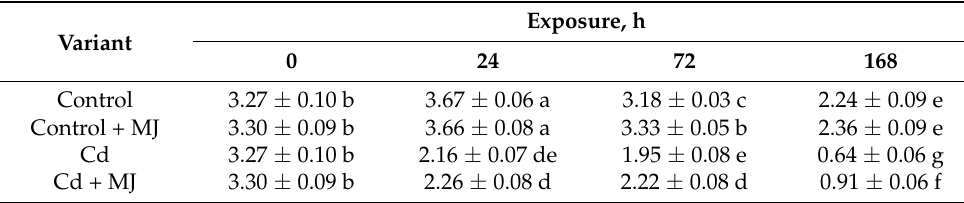
Table 4. Effect of MJ on net photosynthesiss rate ( µ mol CO 2 m − 1 s − 1 ) of wheat seedlings.